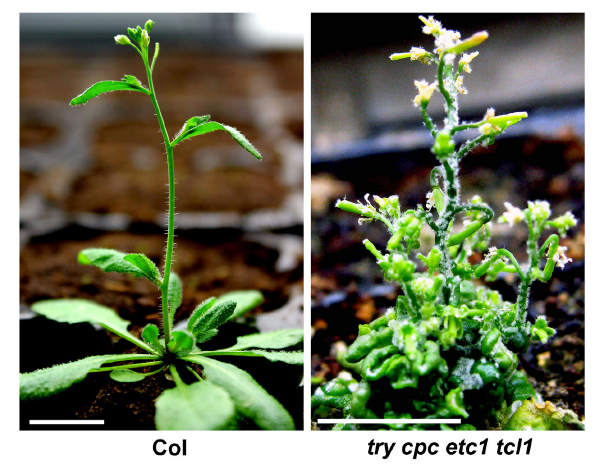
FIGURE 2 | R3 MYB transcription factors function redundantly to control trichome formation in Arabidopsis. In Col wild type plant (left), trichomes were observed on leaves, lower part of stems and flower organs. In try cpc etc1 tcl1 quadruple mutant (right), trichomes were observed in almost all aerial parts of the